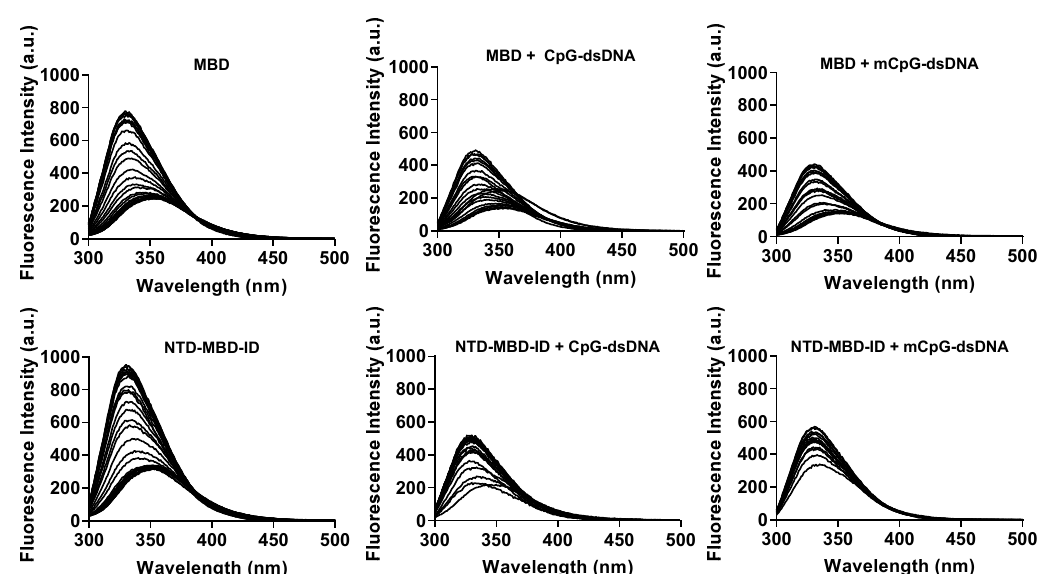
Figure 2. Raw fluorescence spectra for MBD (top) and NTD-MBD-ID (bottom) at different urea concentrations ([ D ] = 0–7 M) in the absence of dsDNA ( left ), in the presence of unmethylated CpG-dsDNA ( middle ), and methylated mCpG-dsDNA ( right ).